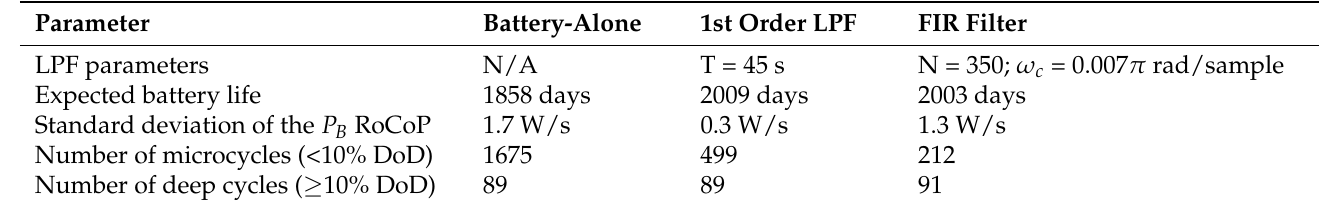
Table 4. Hybridization benefit with the two power